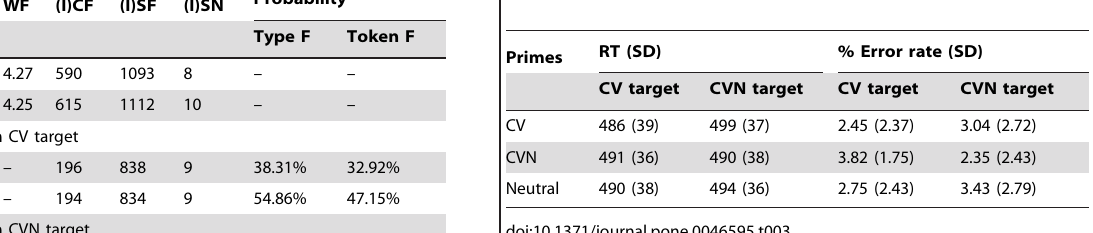
percentage of errors (%) with standard deviation in parentheses in Experiment